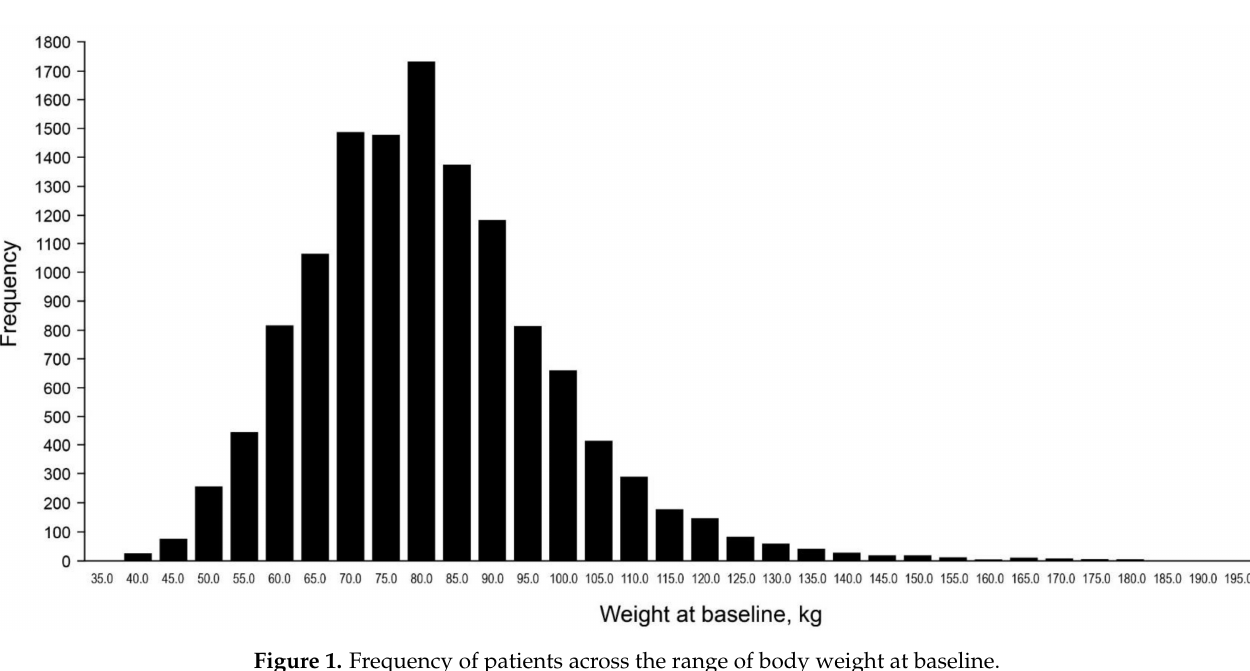
Figure 1. Frequency of patients across the range of body weight at